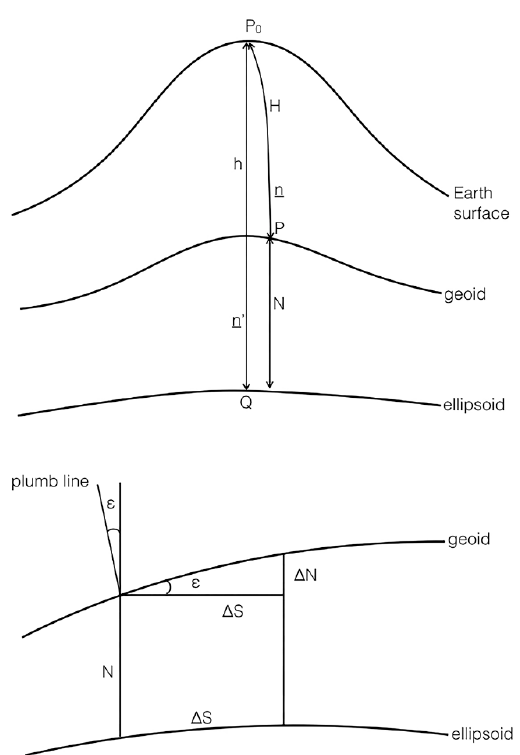
Figure 3. Relation between the geoid undulation N and the deflection of the vertical ε . (Adapted from [27]).